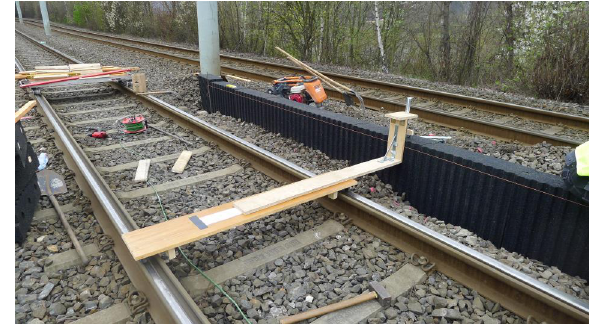
Figure 5. Groove excavation for mounting MNAS using the MHS two-way excavator.